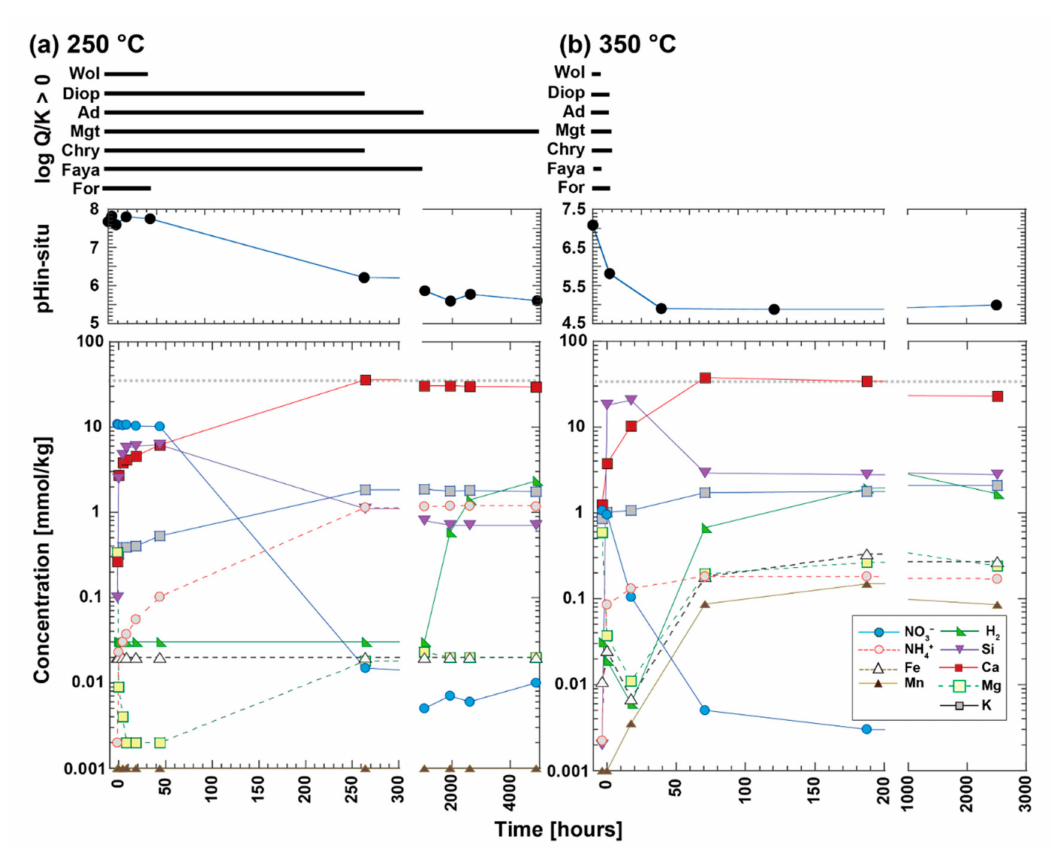
Figure A1. Time trends for saturation index, pH in-situ , and dissolved species concentrations of fluids from experiments in the komatiite–H 2 O–NO 3 − system at 250 ◦ C ( a ) and 350 ◦ C ( b